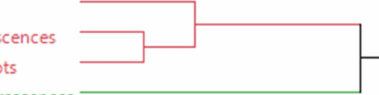
Figure 2. Dendrogram of the Hierarchical Cluster Analysis (HCA) performed on the complete chemical composition of the sample’s